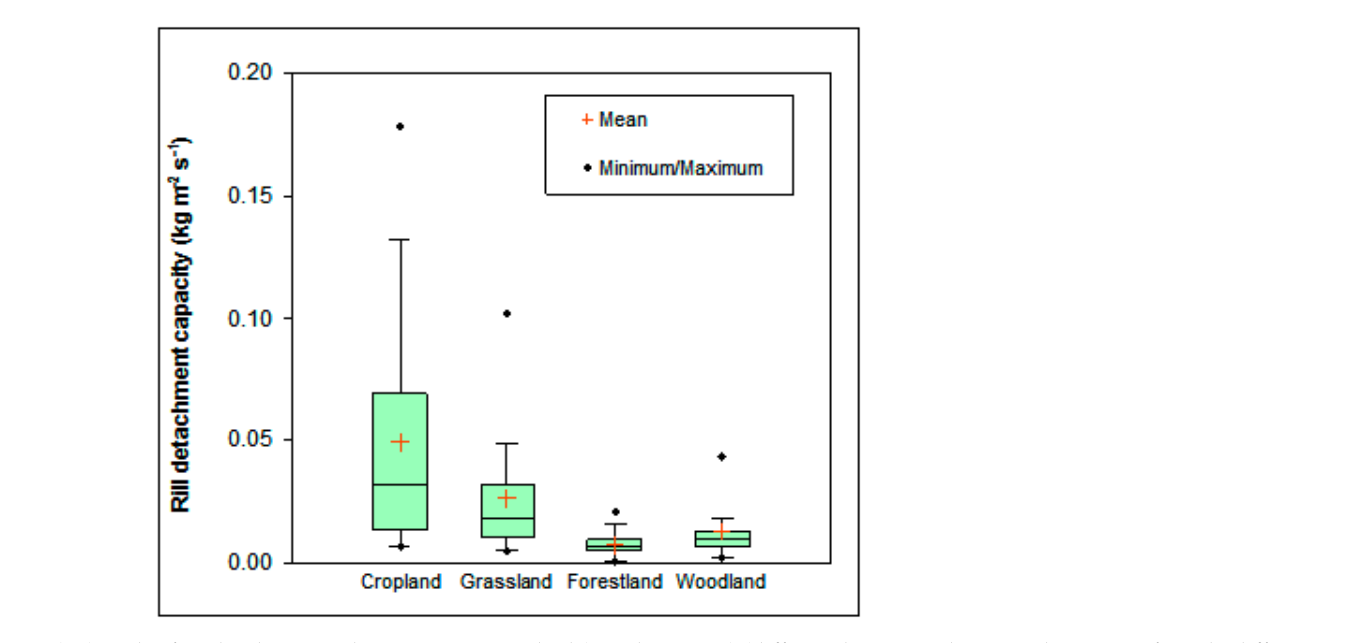
Figure 3. Rill detachment capacity ( D c ) under four land uses in the Saravan watershed (Northern Iran) (different lowercase letters indicate significantly different means at p level < 0.05, n = 25 for each land use).